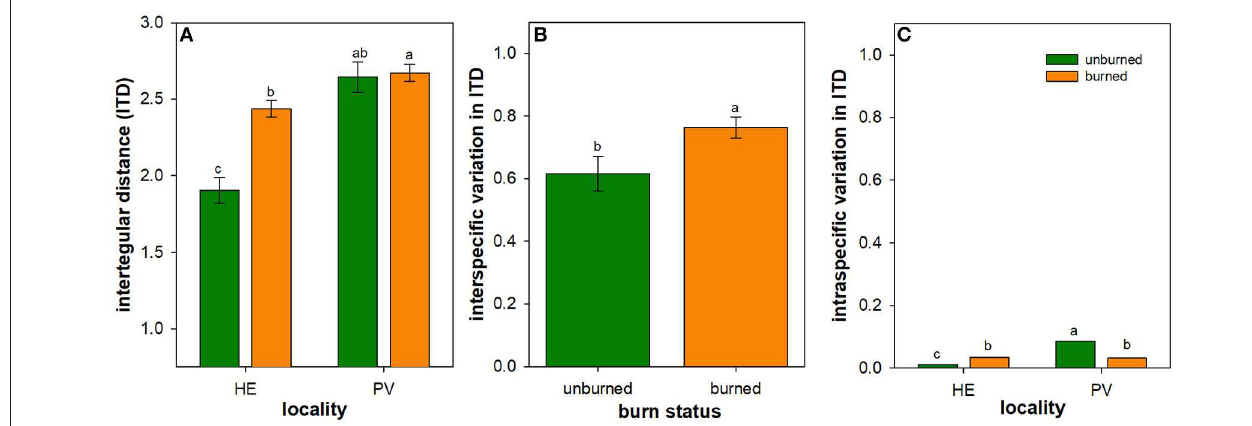
FIGURE 2 | Influence of wildfire on a bee trait and its intraspecific and interspecific variation. Least square mean ( ± 1SE) bee intertegular distance (ITD) (in mm) (A) , and back-transformed least square mean interspecific (B) and intraspecific (C) variation in bee ITD across all individuals of all species measured in burned (orange) and unburned (green) plots. Scaling is consistent between (B,C) for ease of comparison. Only the main effect of burn status is illustrated in panel B due to the lack of interactive effect between locality and burn status in interspecific variation in ITD ( Table 3 ). Letters represent significant differences in means at α = 0.05. N = 16–18 unburned plots per locality; N = 36 burned plots (mixed-severity and high-severity fires) per locality.